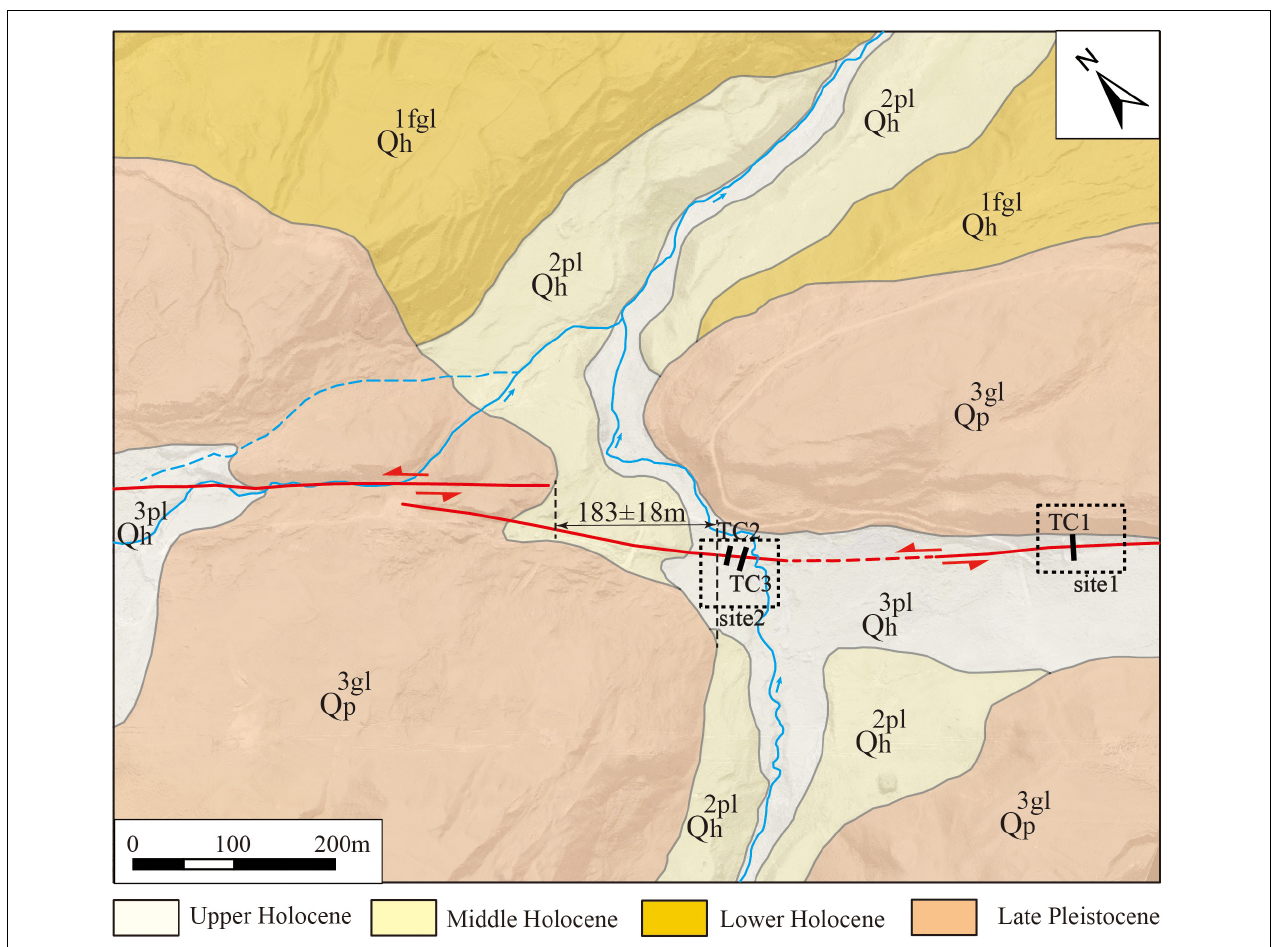
FIGURE 2 | Geological map and distribution of trenches (indicated by black solid rectangles) at the Yousi field site (the location of the black solid square in Figure 1 ).